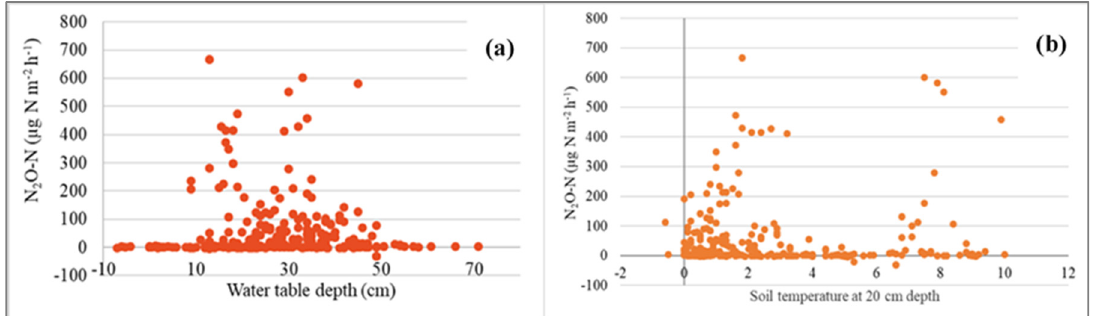
Figure 10. ( a ) Relationship between N 2 O-N emissions and water table depth (cm) across all study sites. Negative water depth values show flooding. ( b ) Relationship between wintertime N 2 O-N emissions and soil temperature at 20 cm depth at all study sites.